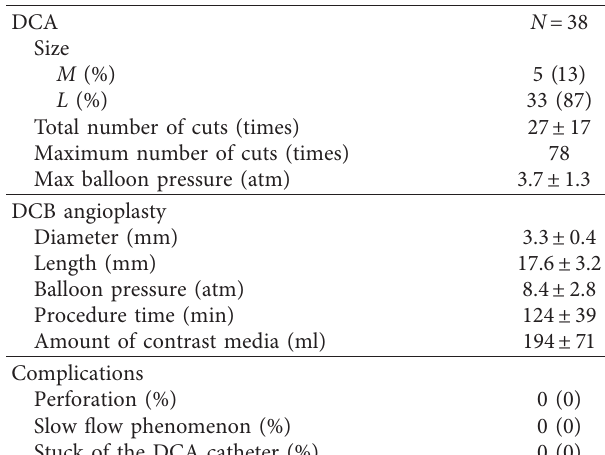
Table 2: Procedural